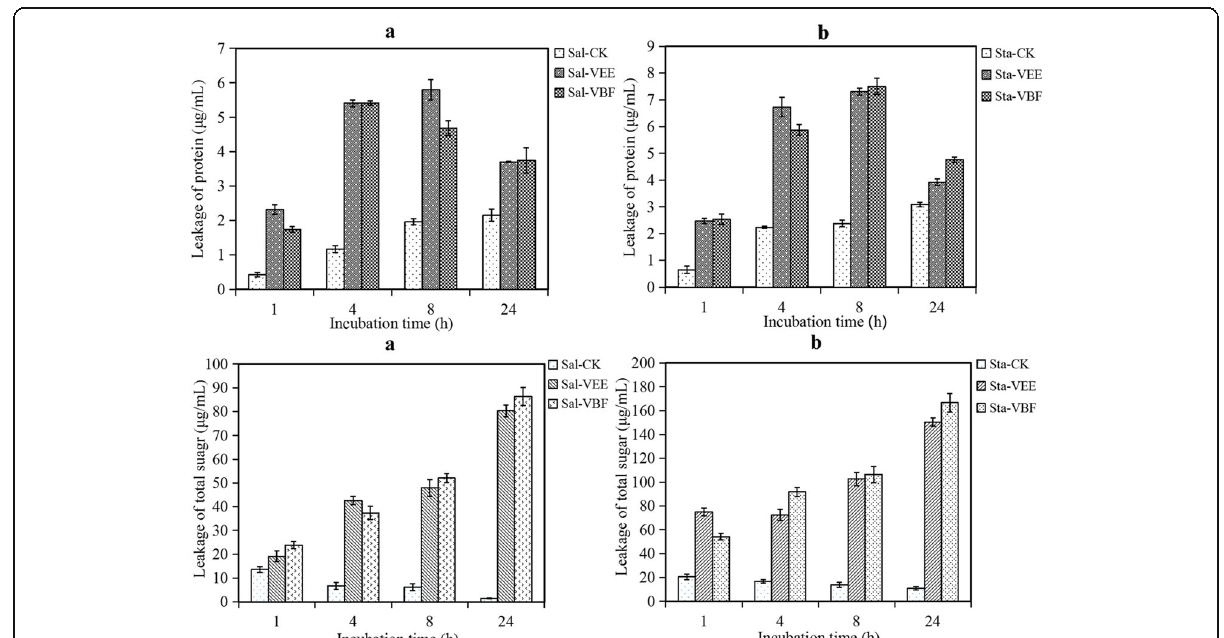
Fig. 2 Leakage of protein and total sugar from S. paratyphi A (Sal, a ) and S. aureus (Sta, b ) cells treated with VEE and